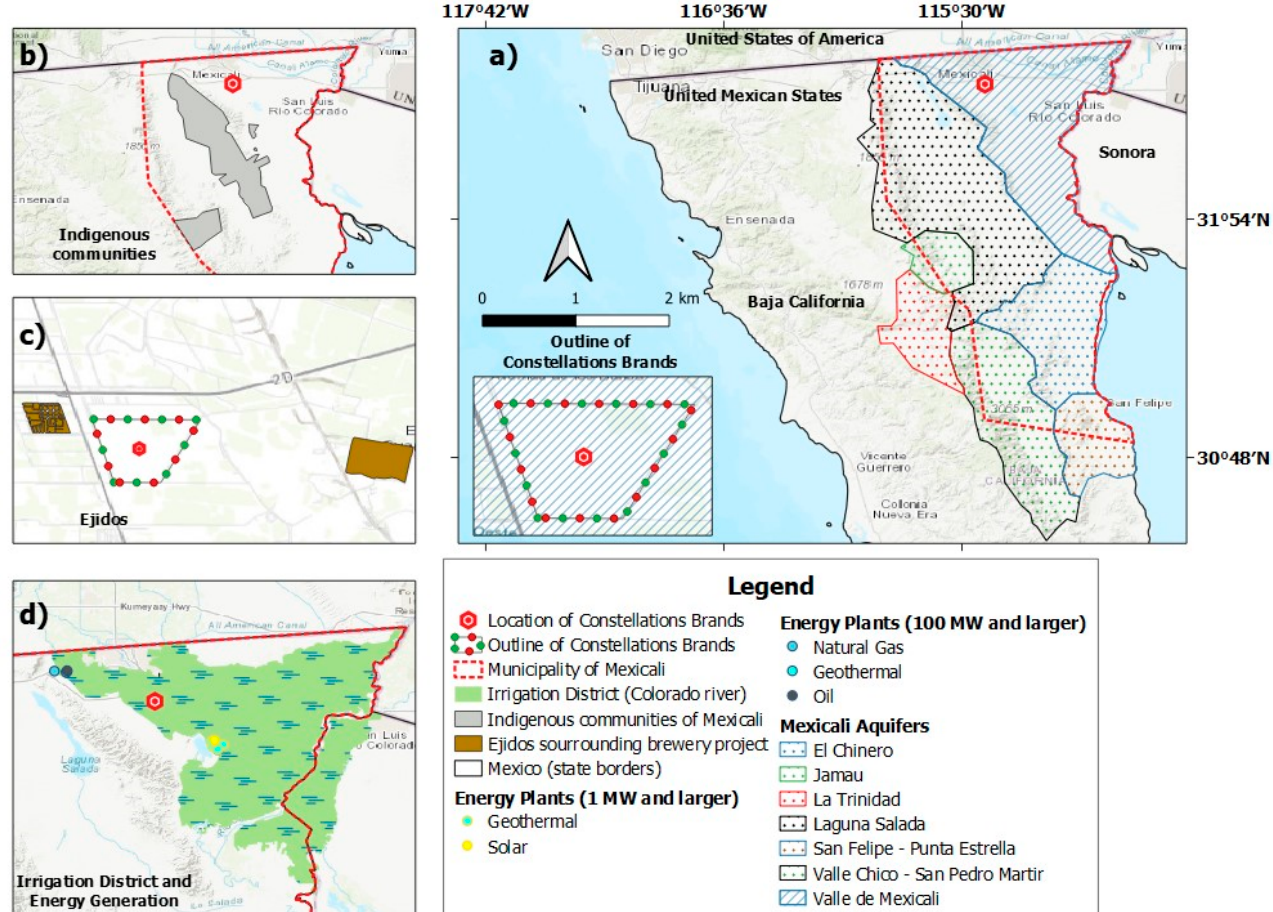
Figure 3. Location of Valle de Mexicali, Baja California. ( a ) Location of the AVM and Constellations Brands; ( b ) Municipality of Mexicali and location of indigenous communities; ( c ) Ejidos surrounding brewery project;( d ) location of Irrigation District and Energy Generation sites. Source. Created with Qgis 3.14.16, with data from the Instituto Nacional de Estadística y Geografía (INEGI). Baja California has a water availability of 3250 Mm 3 year − 1 . The Valle de Mexicali has water availability of 2950 Mm 3 year − 1 , of which 1850 Mm 3 year − 1 is surface water, and 1100 Mm 3 year − 1 is groundwater; the remaining 300 Mm 3 year − 1 is groundwater from the rest of the state and water from dams. The average annual temperature is 22.3 °C., with a mini- mum of below 0 °C. and a maximum of 50 °C. The warm part of the year is from July to September, and December and January are the coldest months. The average precipitation is 82.9 mm/year and average potential evaporation is 2316 mm year − 1 . The most important economic activity is agriculture, which is characterized by cyclical and perennial crops that make this the most important irrigation region in the country. The major crops are cotton and wheat, followed by corn, sorghum, alfalfa, and asparagus [55]. The Valle de Mexicali has an approximate area of 3709 km 2 and is located in a basin of tectonic origin in the seismic zone of the San Andreas Fault. The peninsula is moving away from the continent at a rate of a few centimeters per year [61]. The Valle de Mexicali is bordered on the east by the Colorado River, on the west by the Sierra Cucapá, on the north by the sandy mesa at the border with the U.S., and on the south by the Gulf of California. Because of the lack of precipitation, which averages 100–400 mm annually, 90% of the cultivated area requires mechanized agriculture. An important characteristic of the Valle de Mexicali is its dependence on the Colorado River, whose flow has been dimin- ishing because of climate change and hydrological projects in the U.S. [62].